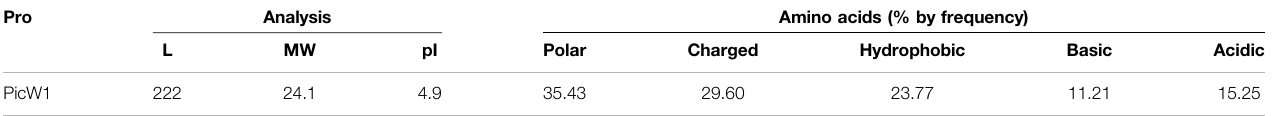
TABLE 1 | Protein and amino acid properties analysis.